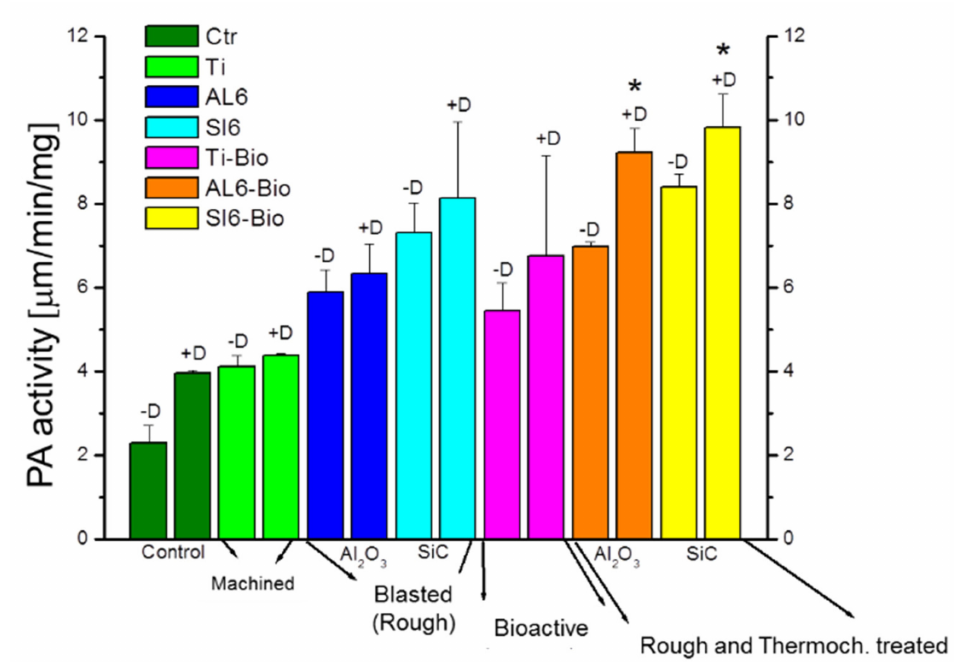
Figure 9. Osteocalcin levels. (* means statistical difference significance).